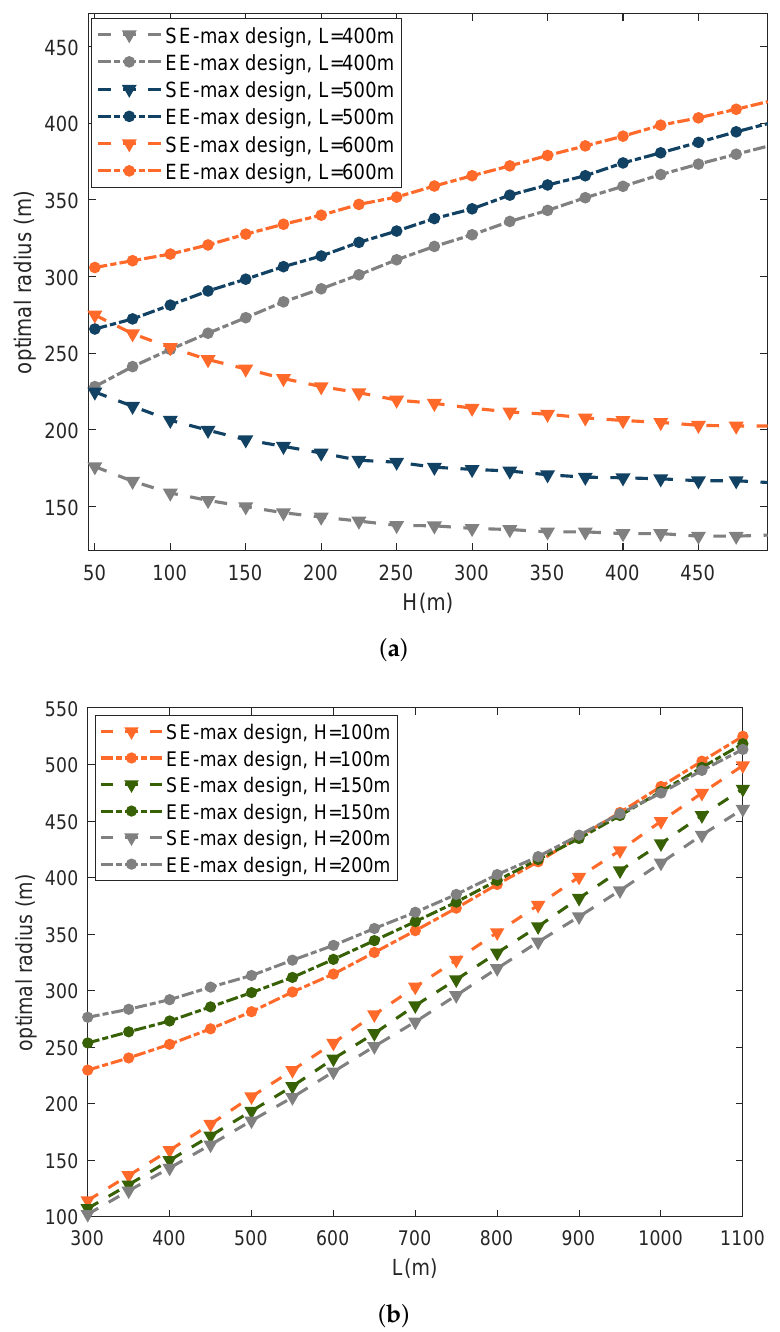
Figure 6. The optimal trajectory radius vs. ( a ) H; ( b )